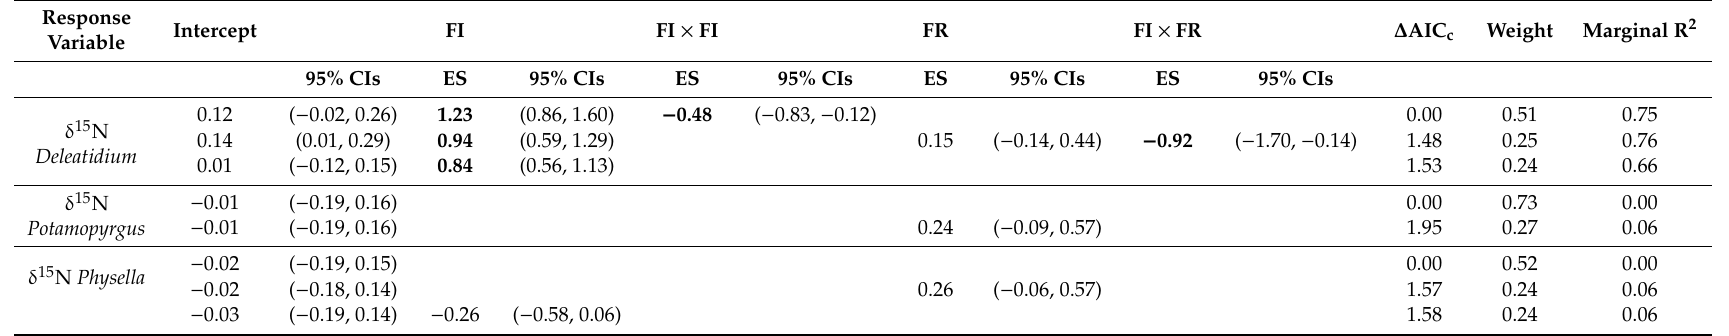
Table 1. Standardized partial regression estimates (e ff ect sizes, ES), 95% confidence intervals CIs, delta AIC (Akaike Information Criterion) di ff erences to the model ranked most highly ( ∆ AICc), Akaike weights (re-scaled), marginal R 2 values (variation explained by the fixed e ff ects) of the final models for the relationships of δ 15 N with sheep / beef farming intensity and flow reduction. E ff ect size categories after Nakagawa & Cuthill [52]: weak > 0.10, moderate > 0.30, strong > 0.50. Estimates in bold indicate where predictors had a significant e ff ect on the response variable (95% CIs not including zero). FI = % Farming Intensity, FR = % Flow Reduction, FI × FI = second-order polynomial terms and FI × FR = interaction